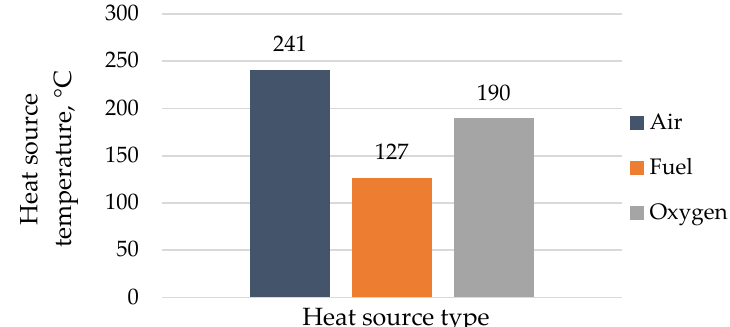
Figure 5. Temperatures of the low-heat sources.